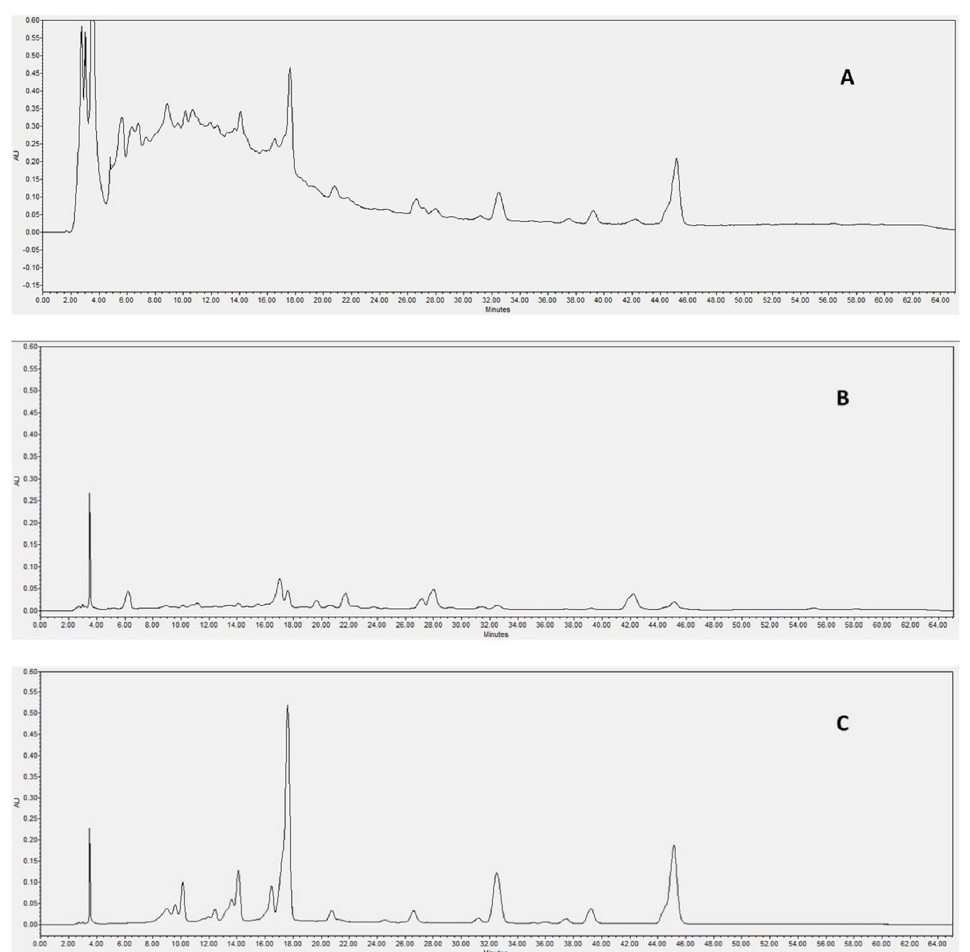
Figure 5. High-performance liquid chromatography with diode array detection (HPLC-DAD) chromatograms of a red grape pomace extract at ( A ) 280 nm, ( B ) 350 nm, ( C ) 520 nm.